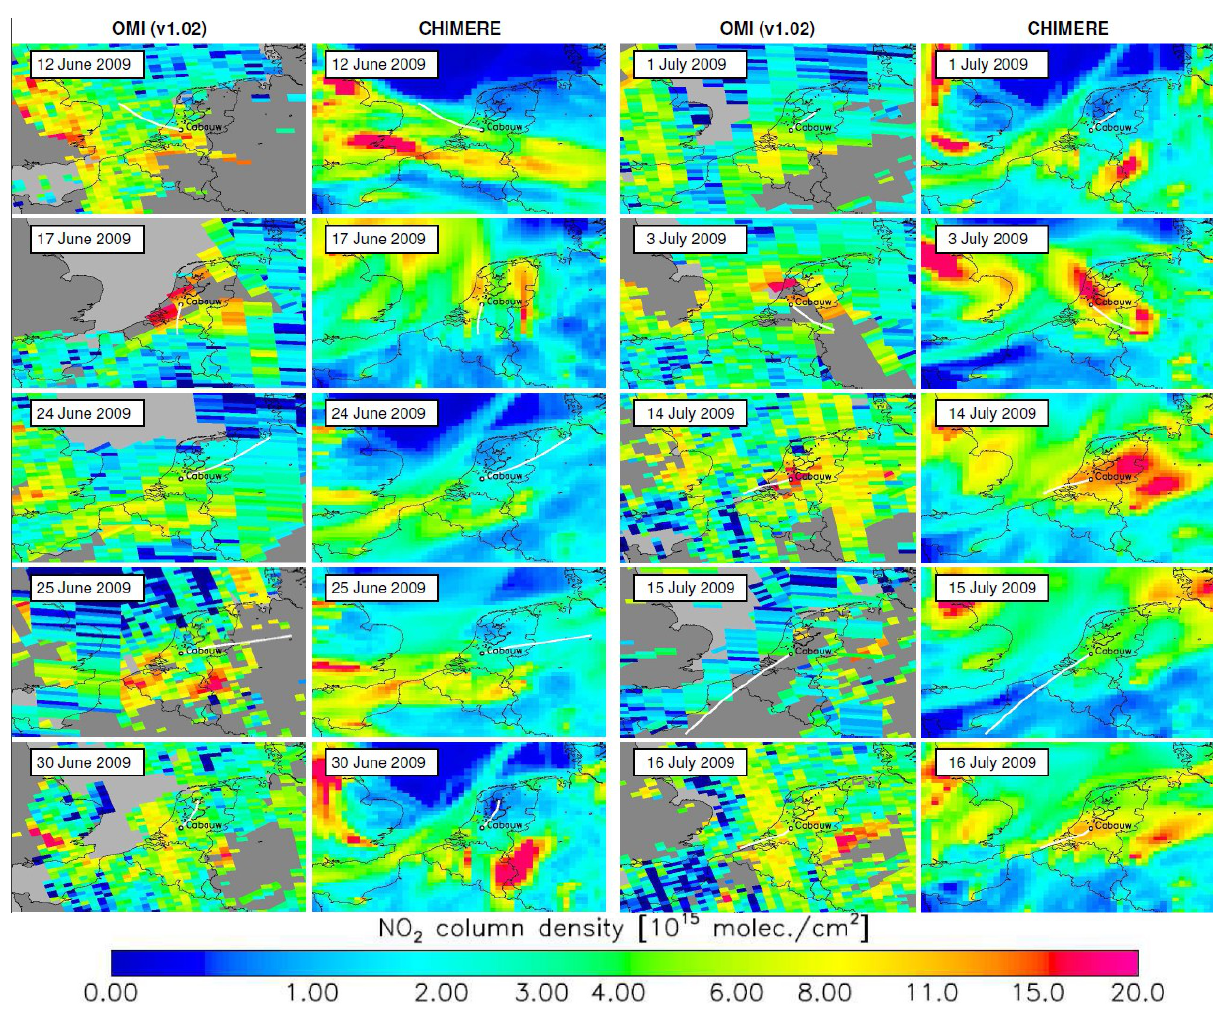
Fig. 8. Tropospheric vertical NO 2 columns observed by OMI and simulated by the CHIMERE chemistry transport model on mostly sunny days at Cabauw during CINDI in June (left columns) and July (right columns) 2009. Grey areas in the OMI (DOMINO v1.02) satellite observations generally indicate cloud radiance fractions > 0.5. The white trajectory shows the path that an air parcel has travelled from 03:00UTC until arriving at Cabauw at 12:00UTC (source: http://www.nilu.no/trajectories/modeldata/2009/cabauw). The OMI observations are performed between 11:00 and 14:00UTC, CHIMERE simulations are shown for